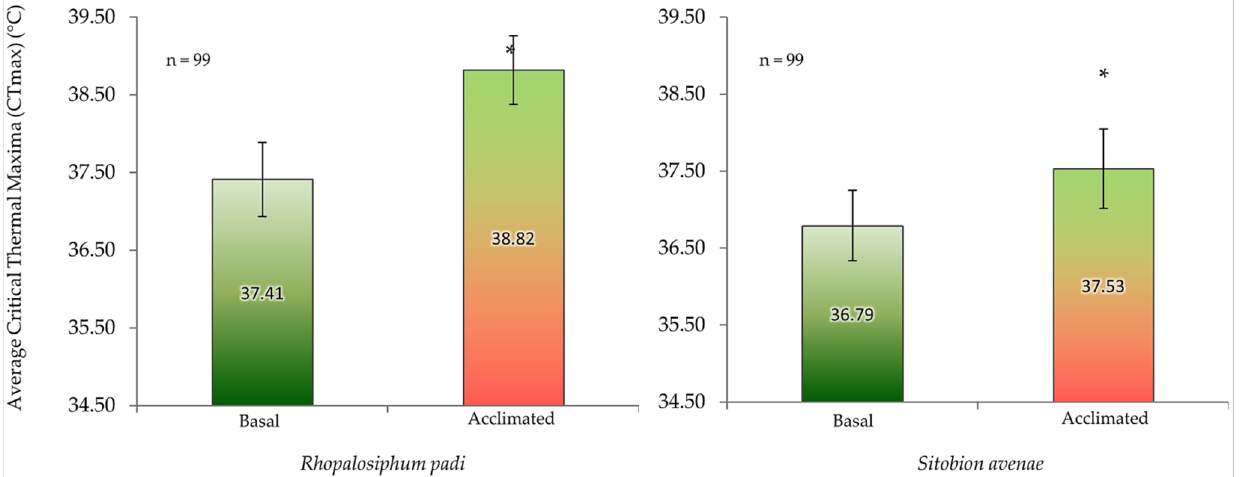
Figure 4. Basal and acclimated critical thermal maxima (CTmax) (mean ± SD; n = 99) of cereal aphids Rhopalosiphum padi and Sitobion avenae . Asterisks indicate significant difference among acclimated